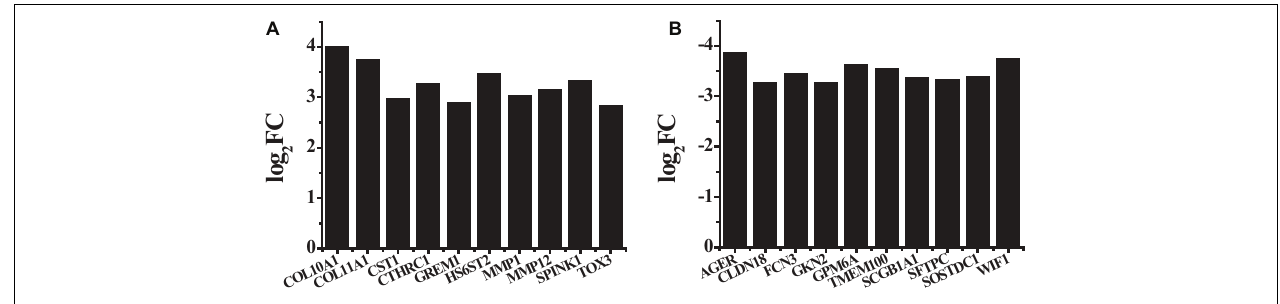
FIGURE 2 | The log 2 FC values of first 10 up-regulated genes and first 10 down-regulated genes that had relatively large differences (A) the first 10 up-regulated genes; (B) the first 10 down-regulated genes.